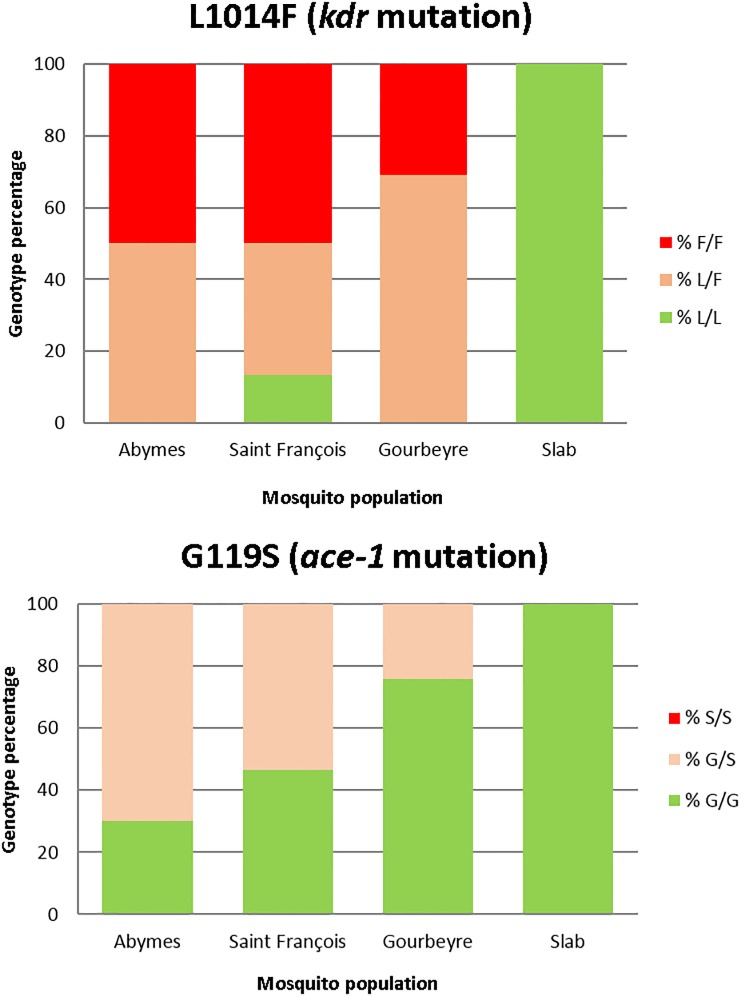
Genotype proportions of the mutations L1014F (kdr) and G119S (ace-1) in the three Culex quinquefasciatus populations studied and the Slab reference strain.L/L: wild homozygote genotype (susceptible); L/F: L1014F heterozygote genotype; F/F: L1014F mutant homozygote (resistant); G/G: G119S wild homozygote genotype (susceptible); G/S: G119S heterozygote genotype; S/S: G119S mutant homozygote (resistant).